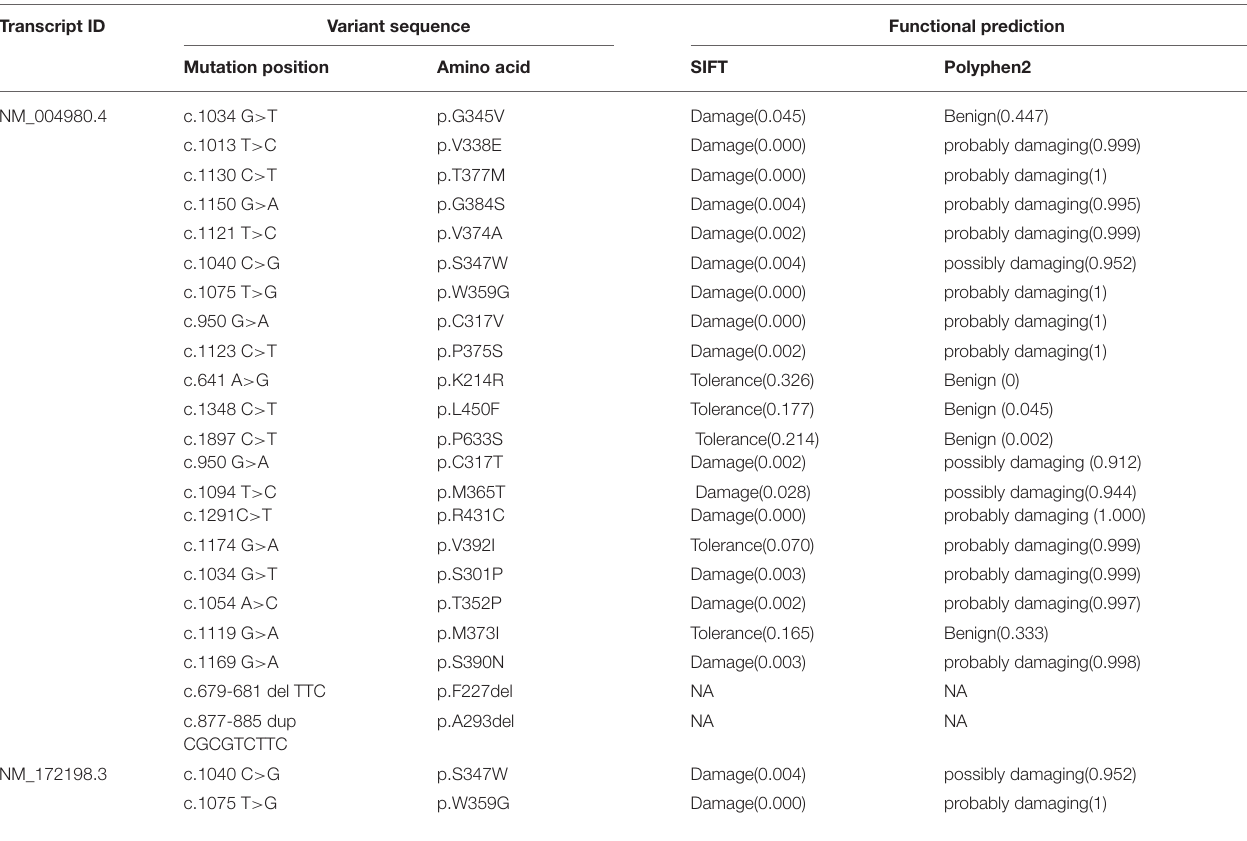
TABLE 2 | The prediction of pathogenicity at different mutation sites of